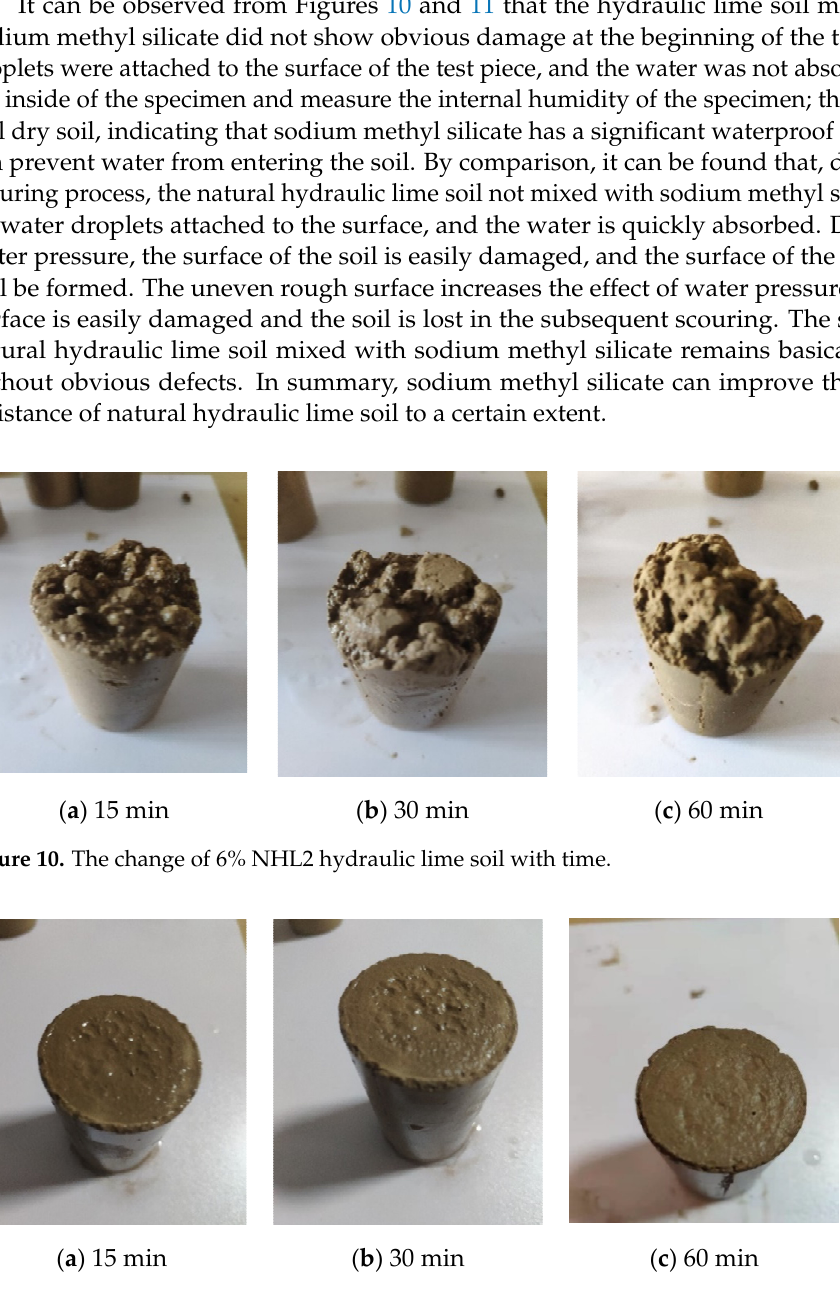
Figure 11. The change of 6% NHL2–0.1% SMS hydraulic lime soil with time.